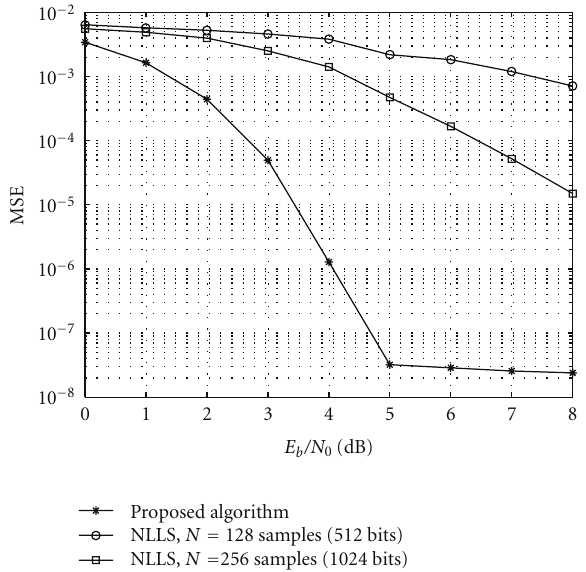
Figure 9: MSE of the carrier frequency o ff set estimation for a 16- QAM.